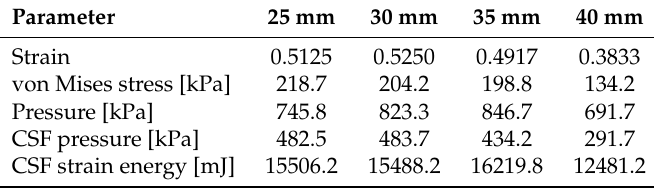
Table 7. Comparison of head injury criteria values computed for various liners